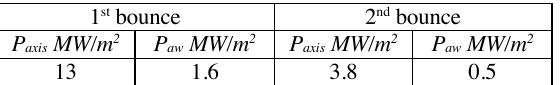
Table 2. Summary of incident peak power density P axis and average power density P aw for the first two